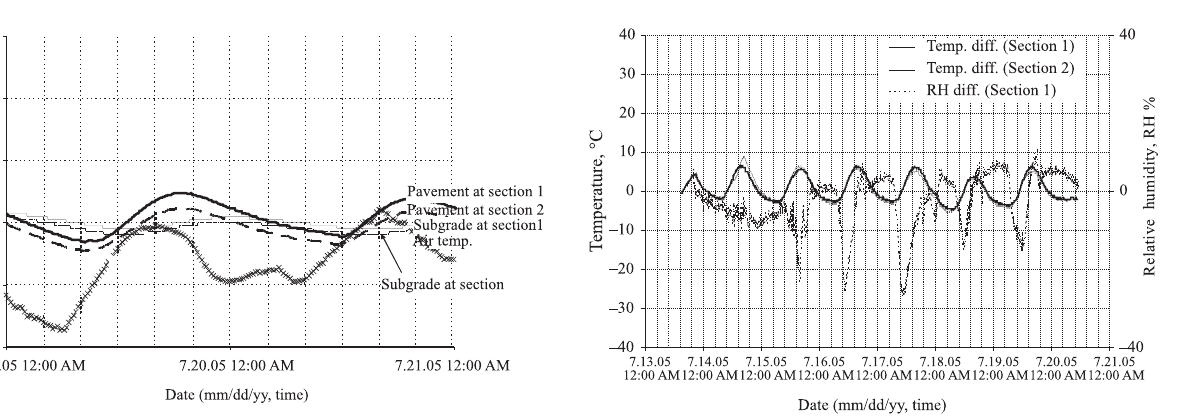
Fig. 3. Temperature variation with time during early aged days (day 6 and day 7)